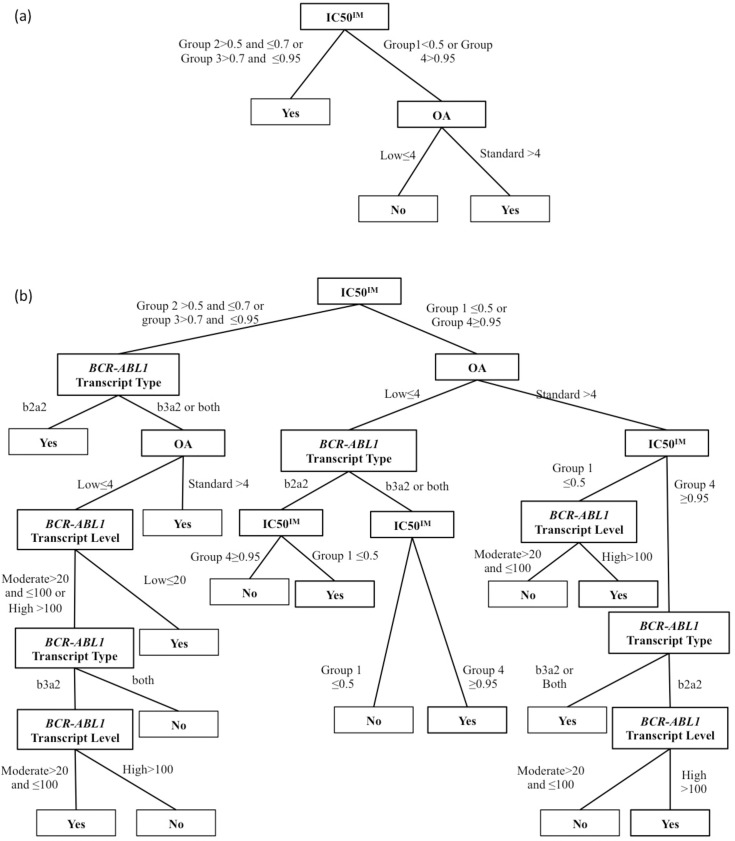
Tree structures for a) Model B and b) Model C. Relations between molecular predictive factors and MMR. The tree represents each predictive factor in nodes. The node has two possible splits: it is connected to either the second predictive factor or the MMR group of patients in the positive or negative group. This graphical structure illustrates the predictive rules. Predictive rules can be used on unseen data to predict the target. A predictive rule of the form: IF (conditions) THEN (class) is equivalent to a path from the root node to leaf in the decision tree, (Yes: achieve MMR at 24 months) and (No: did not achieve MMR at 24 months).